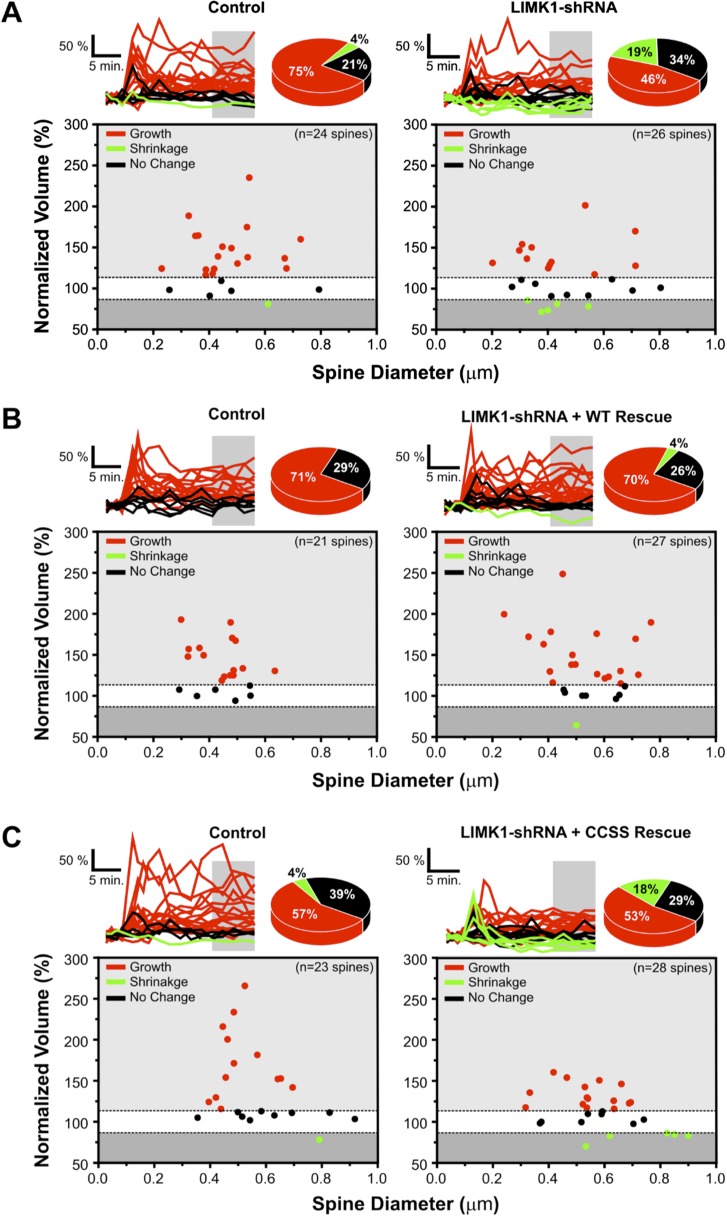
Probability of spine growth or shrinkage in response to glutamate uncaging.(A) Upper left: individual traces for the average data in Figure 5A for control (vector-transfected) neurons. Normalized volumes for each spine, color-coded based on whether spine volume increased (red), decreased (green), or did not change (black) post-uncaging. Pie chart summarizes percentage of spines in each category. Lower left: average normalized spine volume (15–25 min post-uncaging), plotted against initial spine diameters for each spine. Right panels: same as left panels but for spines from LIMK1 ‘knockdown’ neurons. LIMK1 knockdown not only reduced the magnitude of activity-dependent spine enlargement (Figure 6A), but also decreased spine growth success (12/26 spines; 46%) compared with control neurons (18/24 spines; 75%). LIMK1 knockdown also more frequently caused spine shrinkage (5/26 spines; 19%) compared with control neurons (1/24 spines; 4%). (B) Individual traces for average data from Figure 5C, plotted as in A for spines from interleaved control and shRNA-LIMK1 + WT ‘rescue’ neurons. Spine growth success was similar in wt-LIMK1 rescue neurons (19/27 spines; 70%) and controls (15/21 spines; 71%). (C) Individual traces for the average data in Figure 5E, plotted as in A for spines from interleaved control and shRNA-LIMK1 + CCSS ‘rescue’ neurons. CCSS-LIMK1 ‘rescue’ more frequently caused spine shrinkage (5/28 spines; 18%) compared with controls (1/23 spines; 4%).